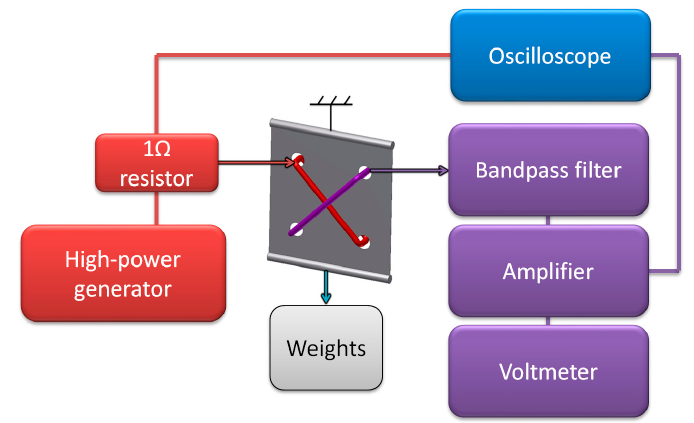
Figure 10. Schematic diagram of the final measurement test stand.